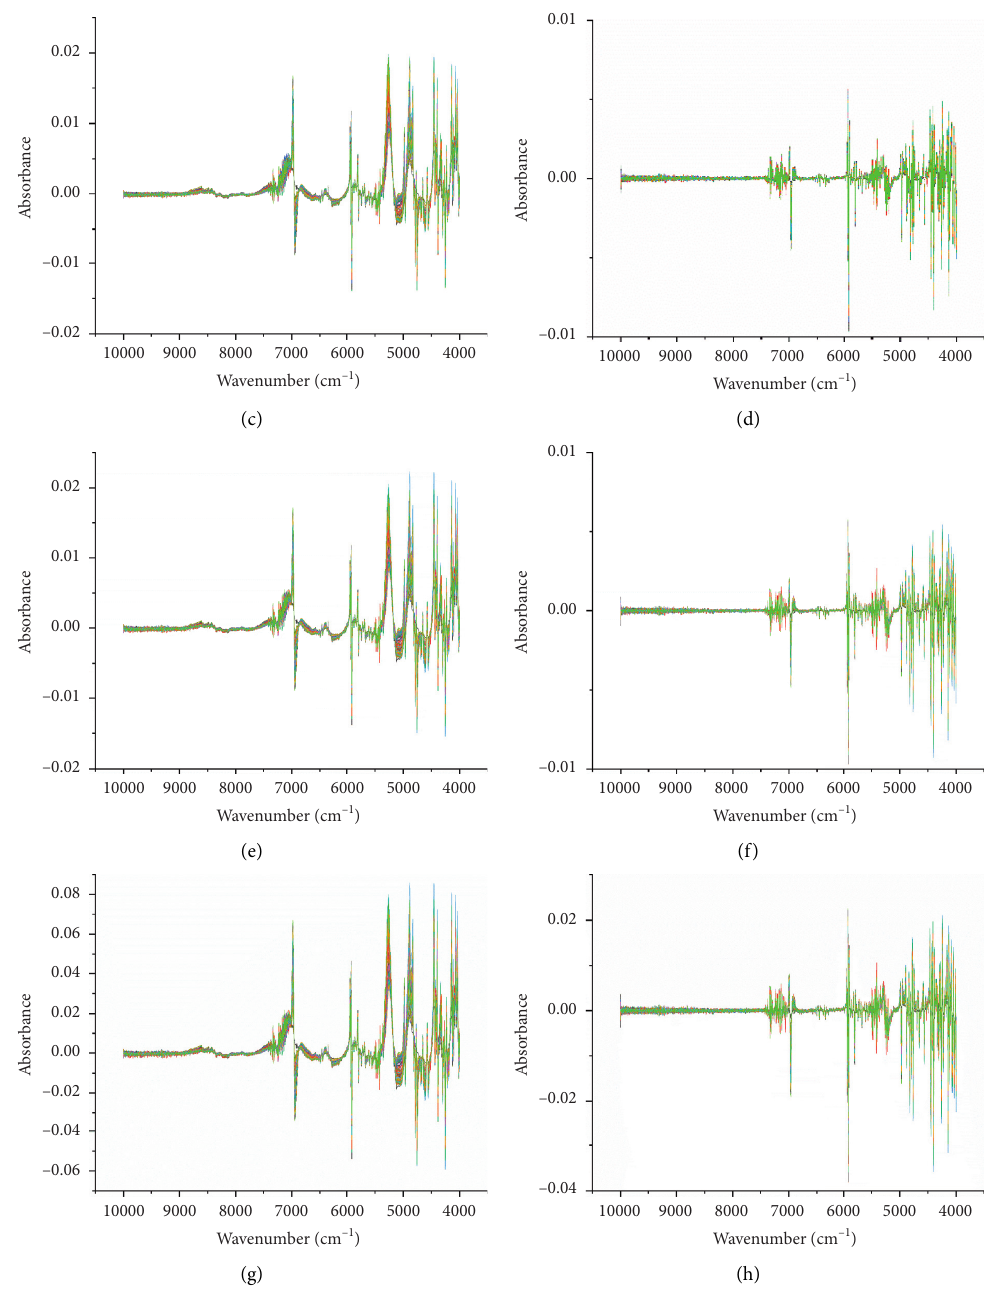
Figure 3: Spectra of different spectral preprocessing methods. (a) Multiplicative scatter correction (MSC). (b) Standard normal variate transformation (SNV). (c) First derivative (Savitzky–Golay algorithm with 11 points of smoothing, 1D). (d) Second derivative (Savitz- ky–Golay algorithm with 11 points of smoothing, 2D). (e) MSC +1D. (f) MSC +2D. (g) SNV+1D. (h)